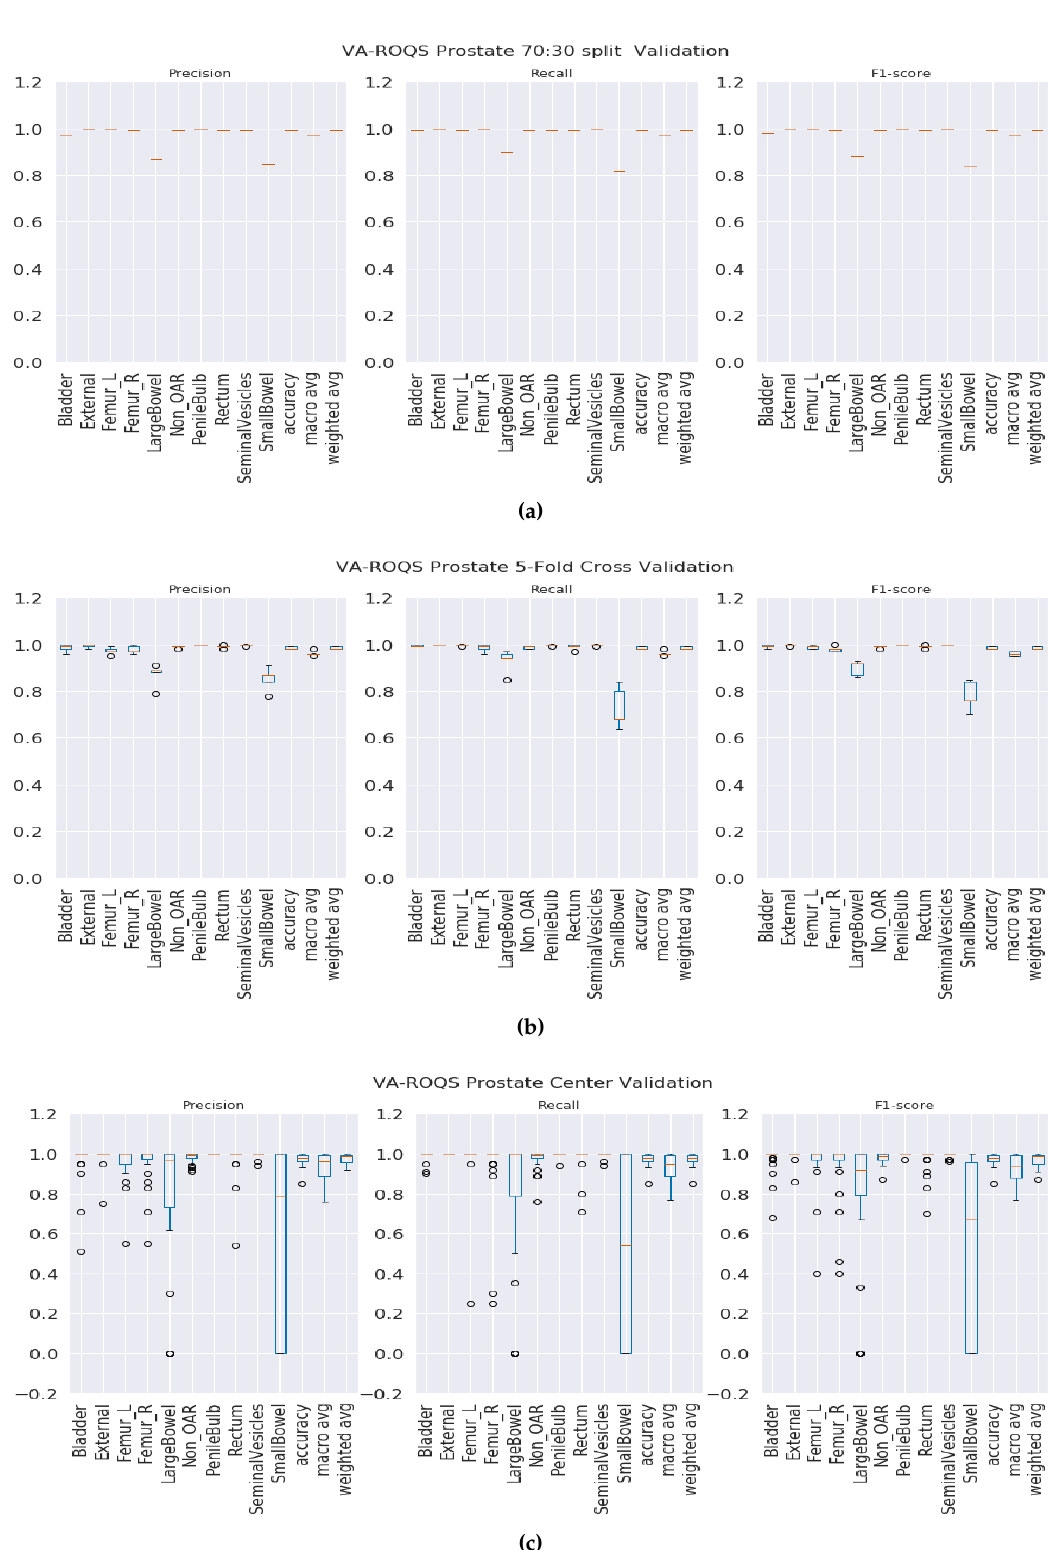
Figure 3. VA-ROQS prostate dataset—cross-validation results: ( a ) VA-ROQS 70:30 split cross-validation, ( b ) VA-ROQS 5-fold cross-validation, ( c ) VA-ROQS center based